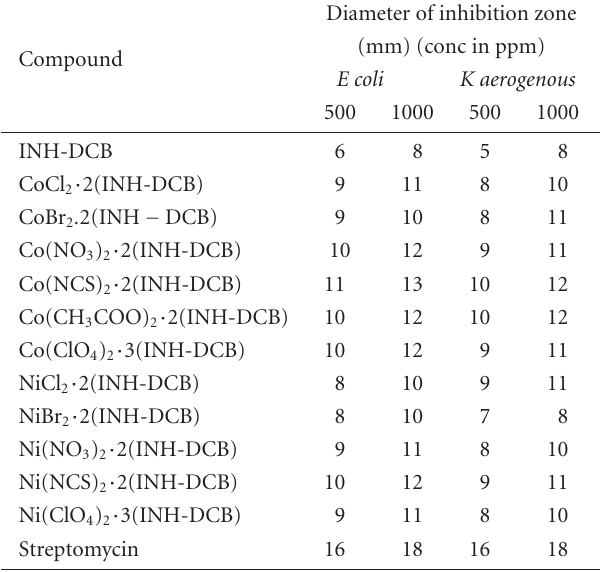
Table 7: Antibacterial screening data of INH-DCB and its Co(II) and Ni(II)